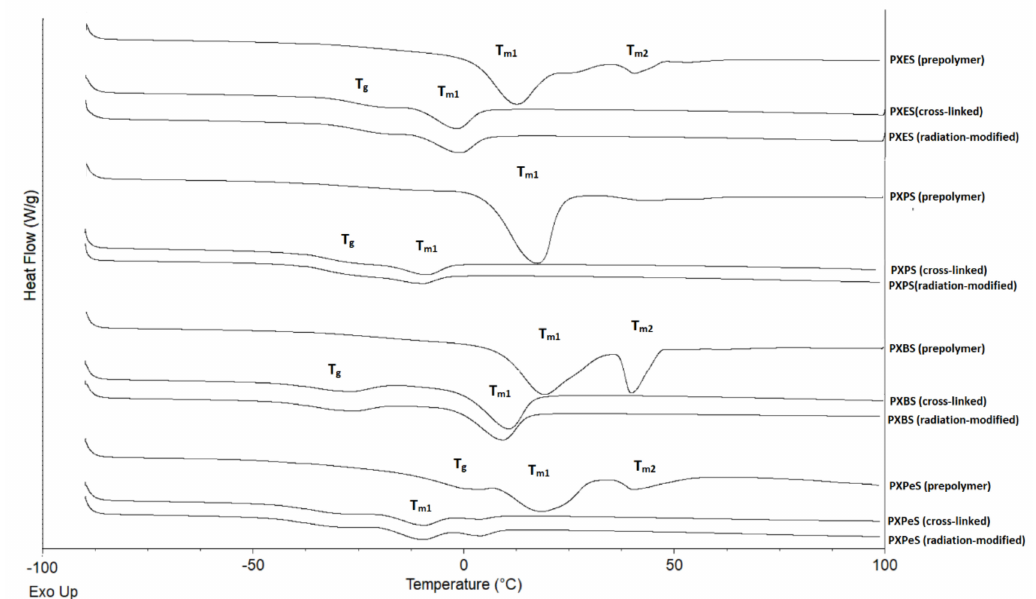
Figure 9. DSC thermograms (first-heating) of PXES, PXPS, PXBS, PXPeS prepolymers, cross-linked polymers, and radiation- modified